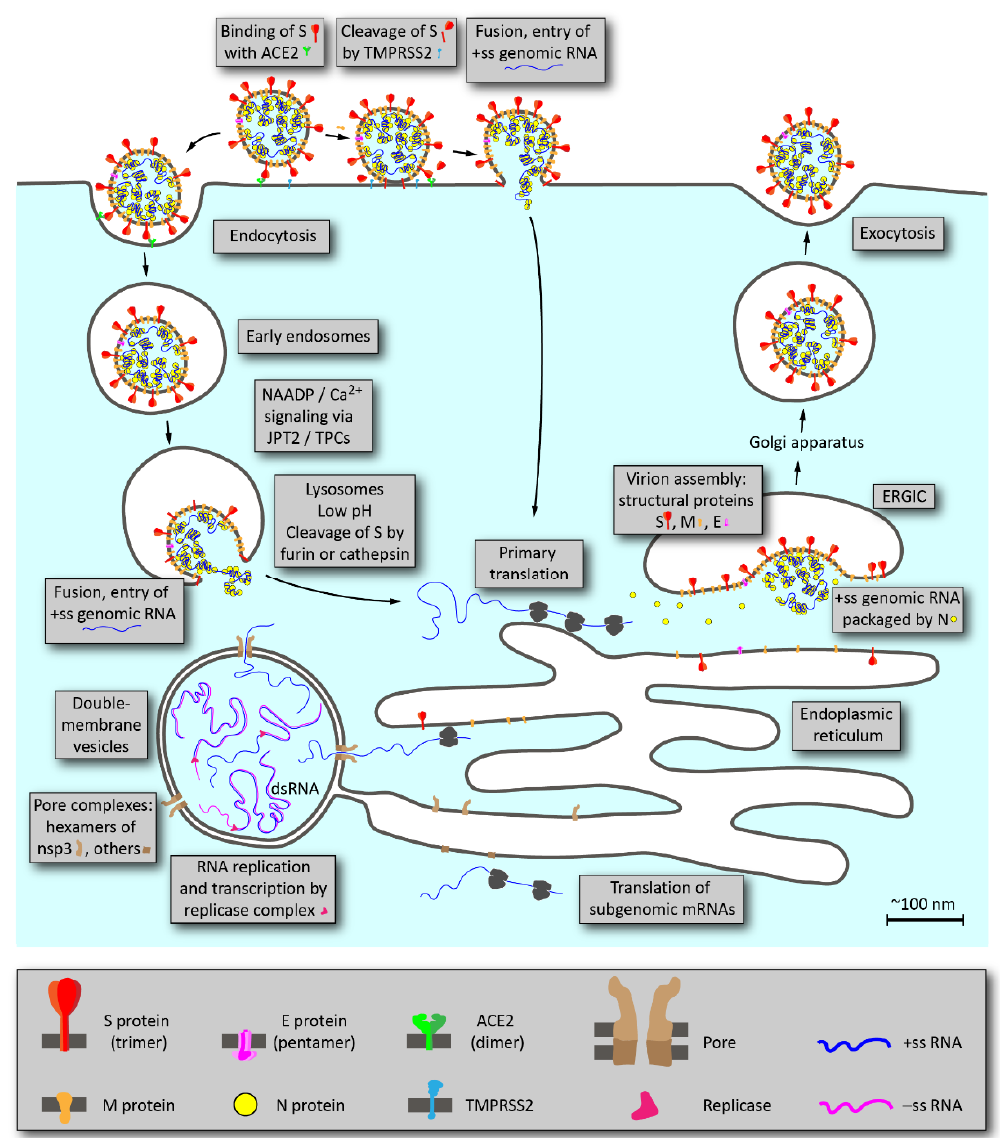
Figure 1. Schematic outline of SARS-CoV-2 life cycle. Proteins and membrane structures are drawn approximately to scale. In the graphical legend at the bottom, elements are magnified 4-fold.